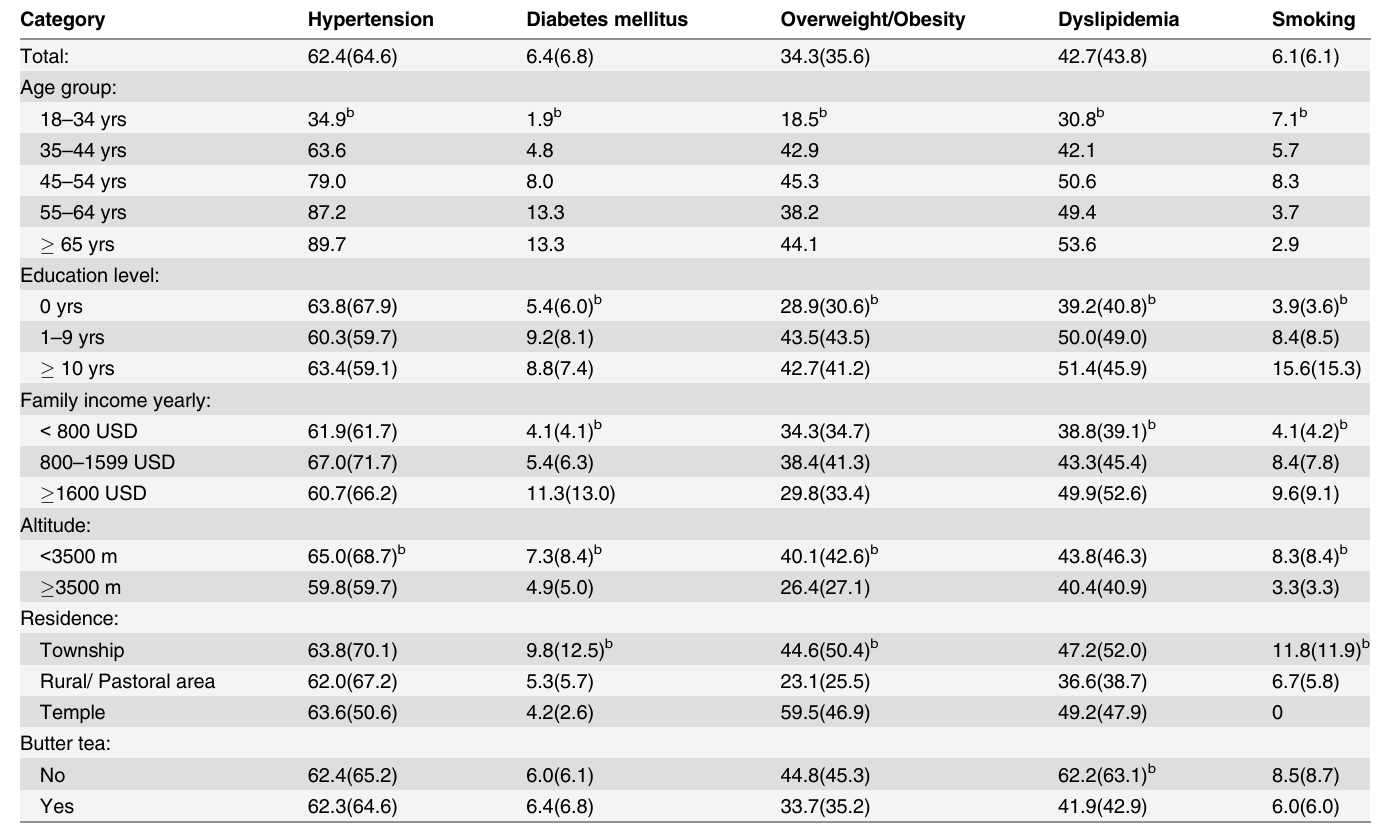
Table 2. The age adjusted prevalence of CVD risk factors by demographic characteristics among Tibetan adults.